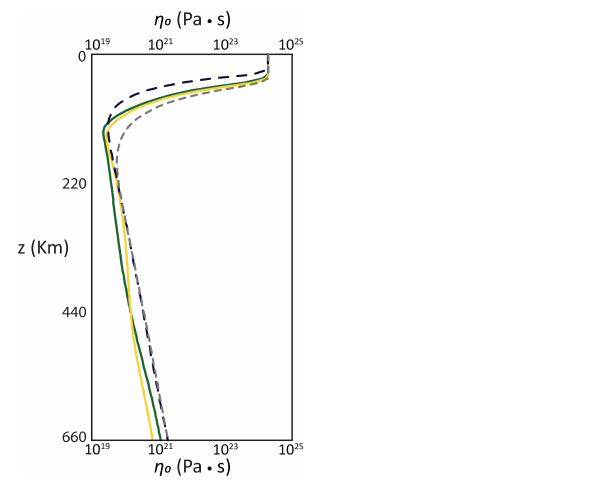
Figure A2. Viscosity profiles representative of the reference case (Fig. 3). As dashed lines, viscosity profiles for the inflow boundary condi- tions: in black, oceanic side; in gray, continental side (see also Manjón-Cabeza Córdoba and Ballmer, 2021). As solid lines, two representative viscosity profiles of the plume at x = 1254km (green line) and x = 1287. Note that due to the plume deflection, a single vertical profile rep- resenting the whole plume is not possible (see also Fig.